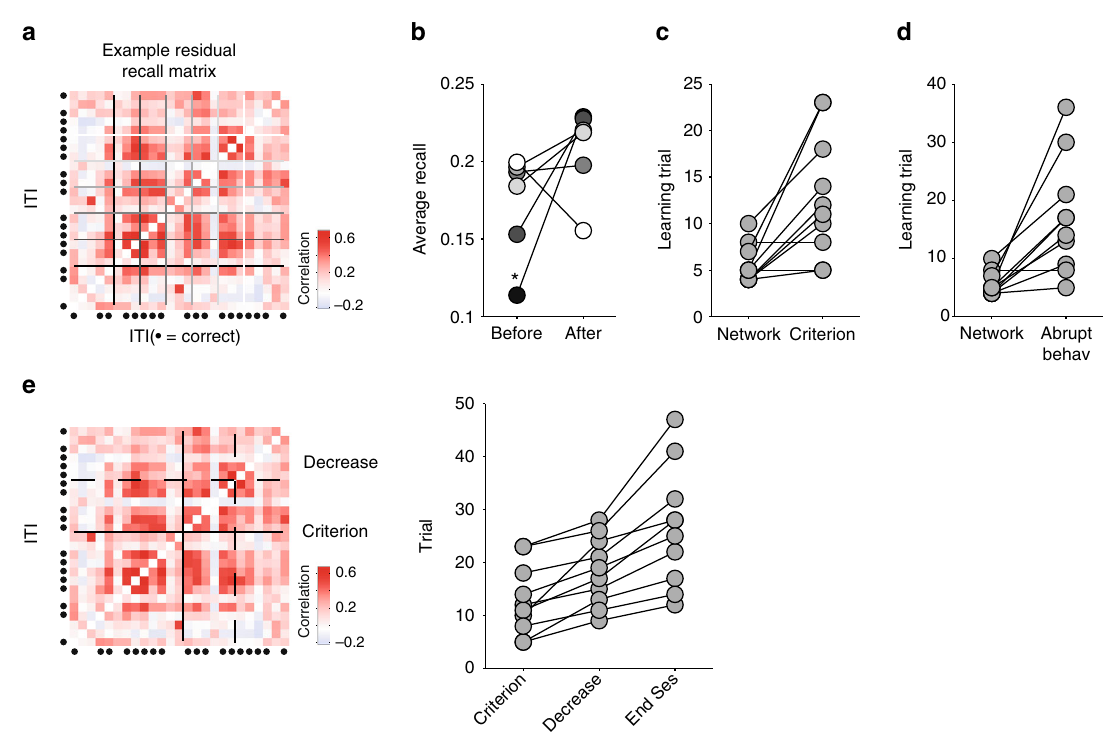
Fig. 4 The recalled ensemble activity pattern anticipates behavioural learning. a A residual recall matrix in its temporal order for one example learning session. Columns are ordered from left to right as the fi rst to last inter-trial interval (rows ordered bottom to top). For each inter-trial interval, the distributions of the recall values before and after the selected inter-trial interval were compared (Kolmogorov – Smirnov statistic: see Methods). Each grey scale line corresponds to the selected subset of the dividing inter-trial intervals plotted in b . b For each grey scale line in a , the corresponding average recall value before and after the dividing inter-trial interval. The asterisk indicates the inter-trial interval with the largest increase in recall after it, signalling the abrupt appearance of the recalled ensemble pattern. c Comparison of the learning trial identi fi ed by the original behavioural criterion with the identi fi ed onset trial for the recalled ensemble activity pattern ( ‘ Network ’ ). d As c , but with the behavioural learning trial identi fi ed as the trial with the steepest change in the cumulative reward (Methods). e Testing for decay of the ensemble activity pattern. Left panel: example residual recall matrix in trial order for one learning session. The black solid line is the learning trial, while the dashed line is the identi fi ed offset of the recalled ensemble activity pattern. Right panel: For each learning session the learning trial (original criterion) is compared to the identi fi ed offset of the ensemble recall, and to the last trial of